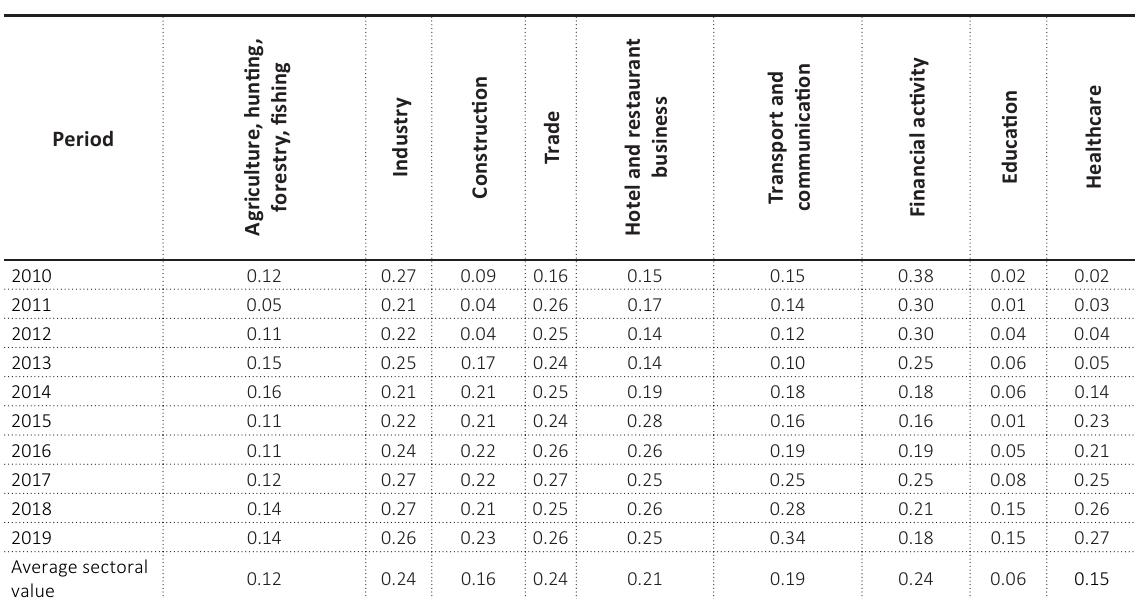
Table 3. Calculation of the integrated indicator of investment attractiveness of the economy